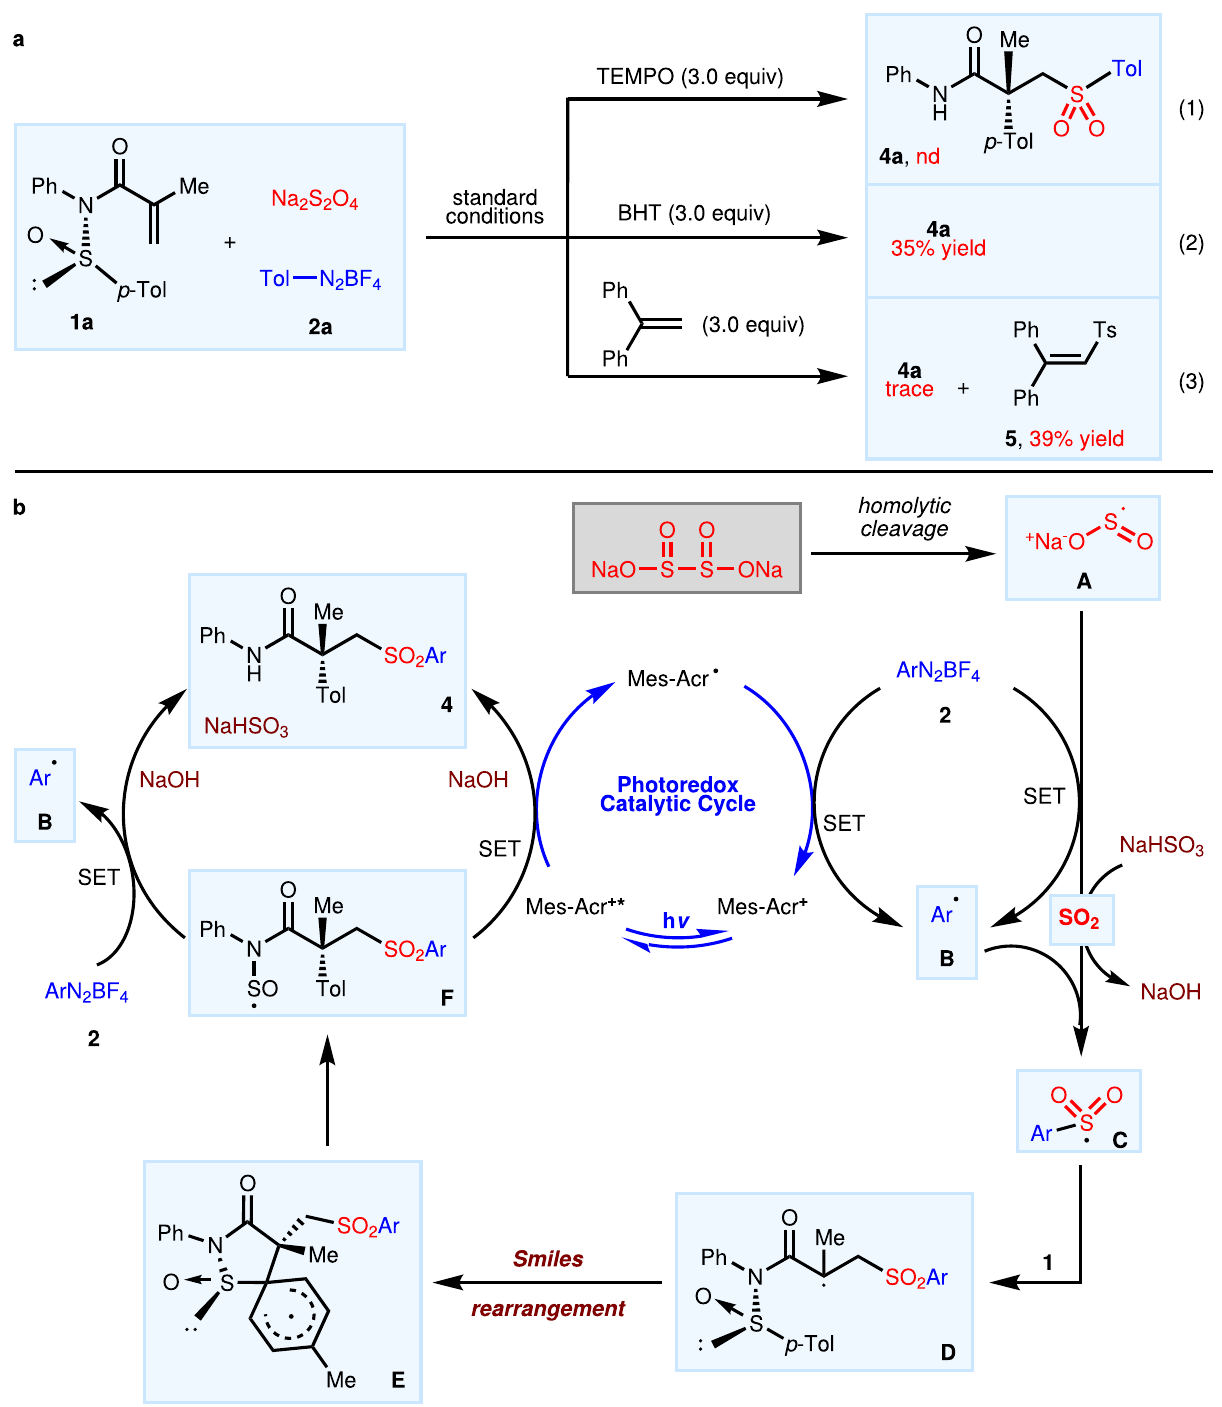
Fig. 4 | Control experiments and plausible mechanism. a Control experiments: (1)WithTEMPOasaradicalscavenger;(2)WithBHTasaradicalscavenger;(3)With